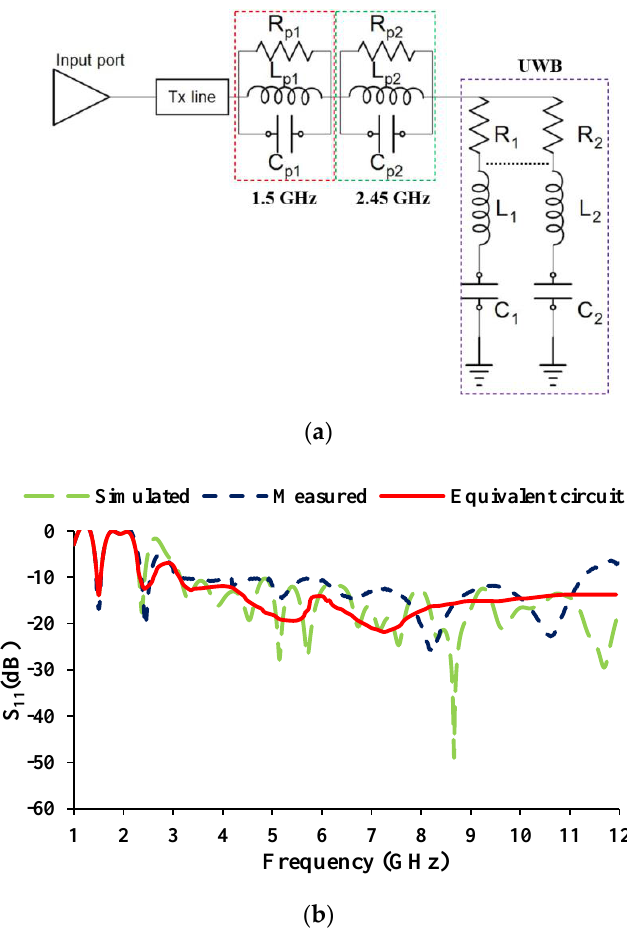
Figure 6. Equivalent circuit of the antenna ( a ) model, ( b ) S-parameters.